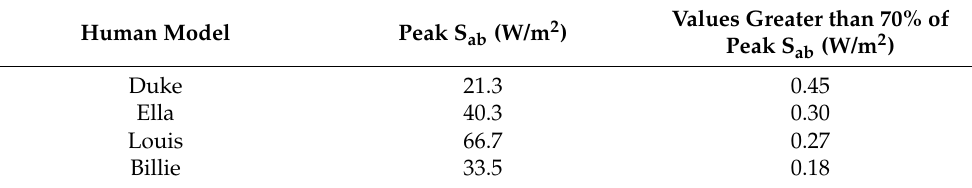
Table 4. Peak S ab and percentage of S ab values greater than 70% of peak S ab for each